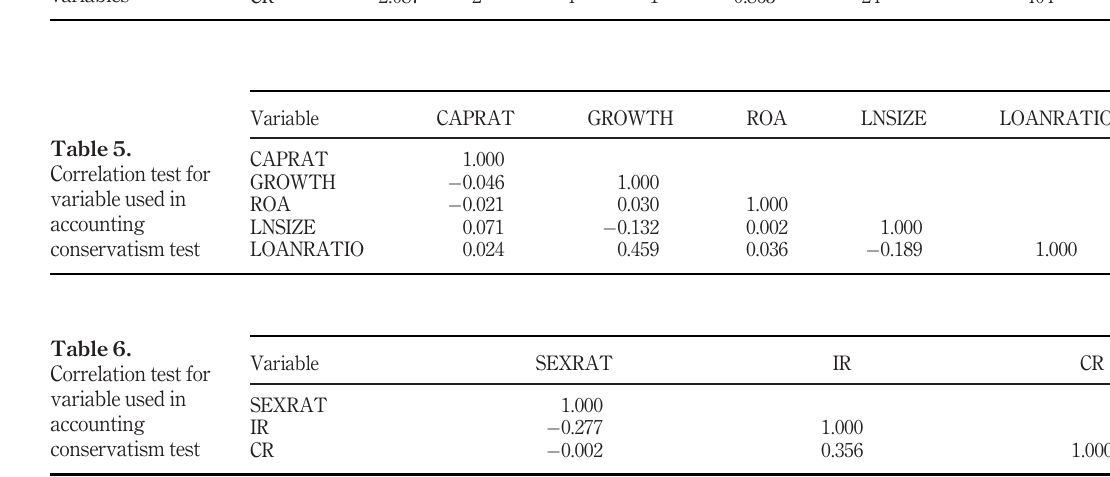
Table 4. Institutional-level